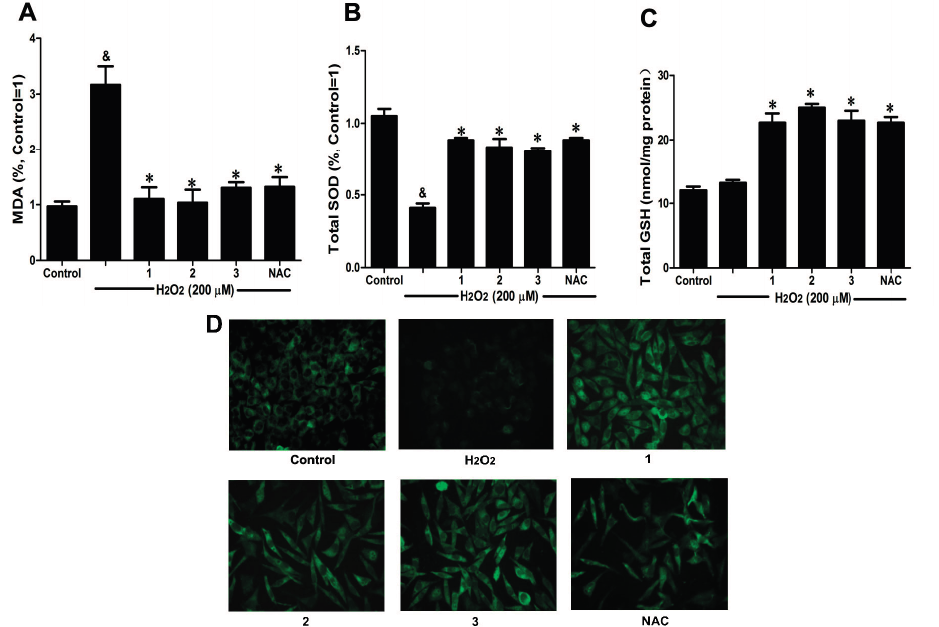
Figure 4. Effects of Danshensu-cysteine conjugates on intercellular anti-oxidative capacity in H 2 O 2 -stimulated SH-SY5Y cells. SH-SY5Y cells were incubated with Danshensu-cysteine conjugates (all at 50 μ M) or NAC (5 mM) for 4 h, then stimulated with H 2 O 2 (200 μ M) for 12 h; the malondialdehyde (MDA) ( A ) production, superoxide dismutase (SOD) ( B ) and reduced glutathione (GSH) ( C ) activities were measured, respectively. Data shown are means ± SEM, & p < 0.05 compared with unstimulated cells, * p < 0.05 compared with H 2 O 2 -stimulated cells. Data were from at least three independent experiments, each performed in duplicate; ( D ) Representative pictures showing glutathione peroxidase (GPx) expression by immunofluorescent staining (magnification,